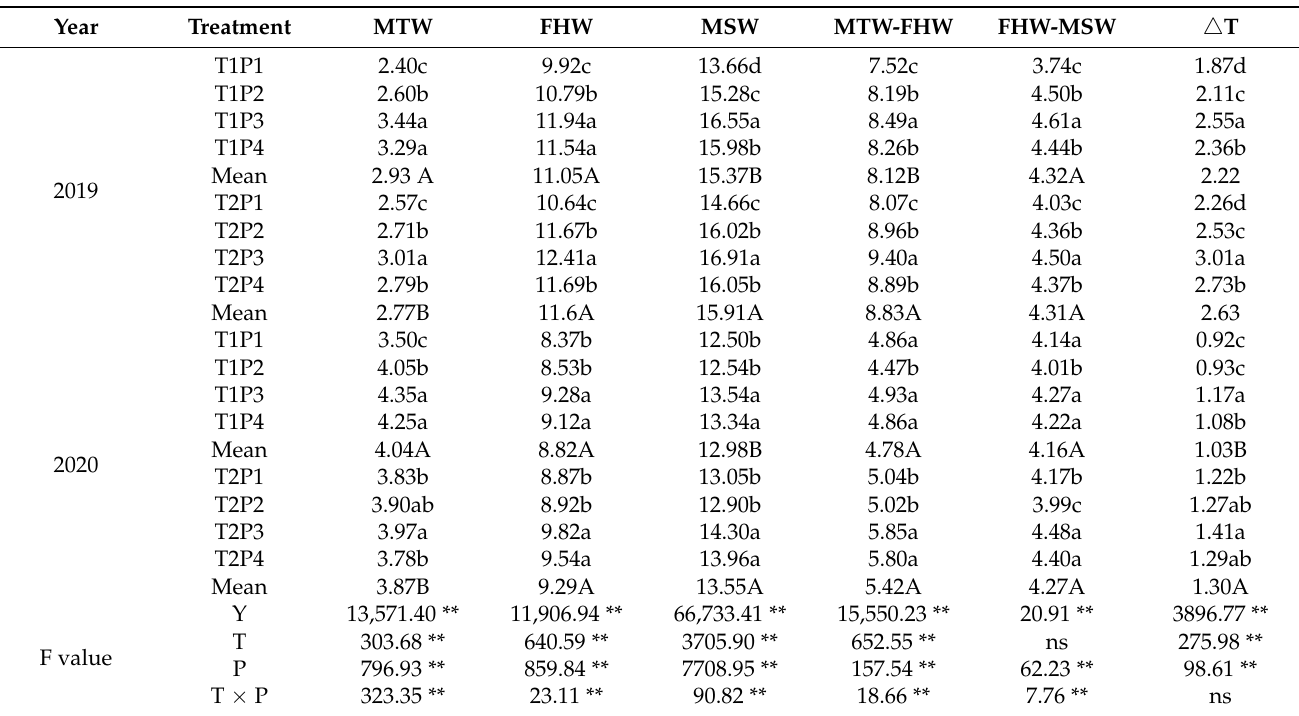
Table 3. Dry matter accumulation and pre-flowering dry matter output of rice during the main growth periods under different treatments in 2019 and 2020 (t · ha − 1